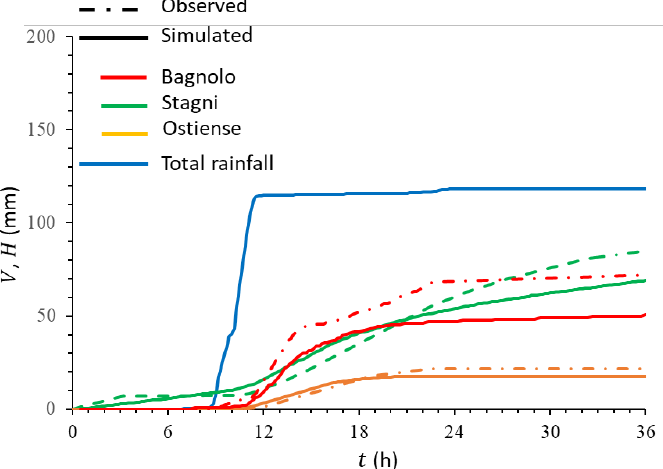
Figure 8. Event of 10 September 2017: comparison between observed and simulated water volumes (per unit catchment area) and comparison with the total rainfall.